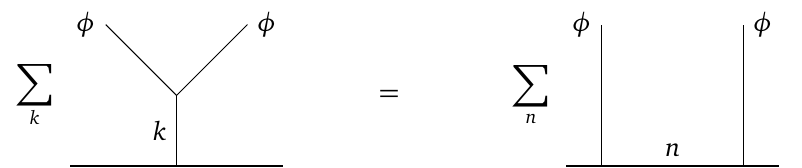
Figure 3: Depiction of crossing symmetry for the two-point function in